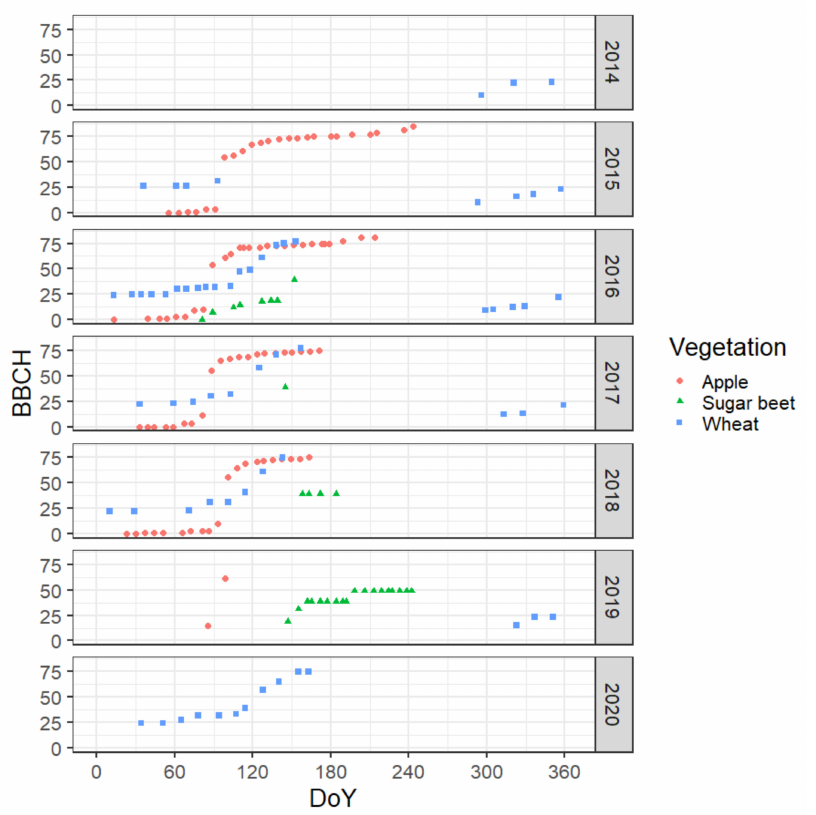
Figure 5. Phenology